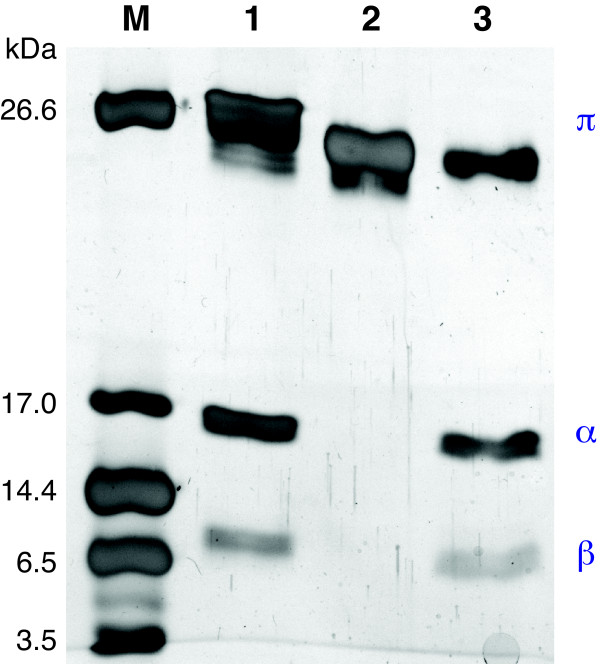
SDS-PAGE analysis of affinity-purified proteins shows the AaxB variant proteins self-cleaved in E. coli. Lane M contains polypeptide markers (Bio-Rad). Lane 1 contains the X128W variant of His6-AaxB from strain L2/434, including proenzyme (26 kDa expected, 26 kDa observed), α-subunit (16 kDa expected, 16 kDa observed) and β-subunit (10 kDa expected, 8 kDa observed). Lane 2 contains His10-AaxB from strain D/UW-3, including only proenzyme (24 kDa expected, 25 kDa observed). Lane 3 contains the R115G variant of His10AaxB from strain D/UW-3, including proenzyme (25 kDa expected, 25 kDa observed), α-subunit (16 kDa expected, 16 kDa observed) and β-subunit (9 kDa expected, 6 kDa observed). The gel was stained with silver, and the image was processed as described for Figure 2.